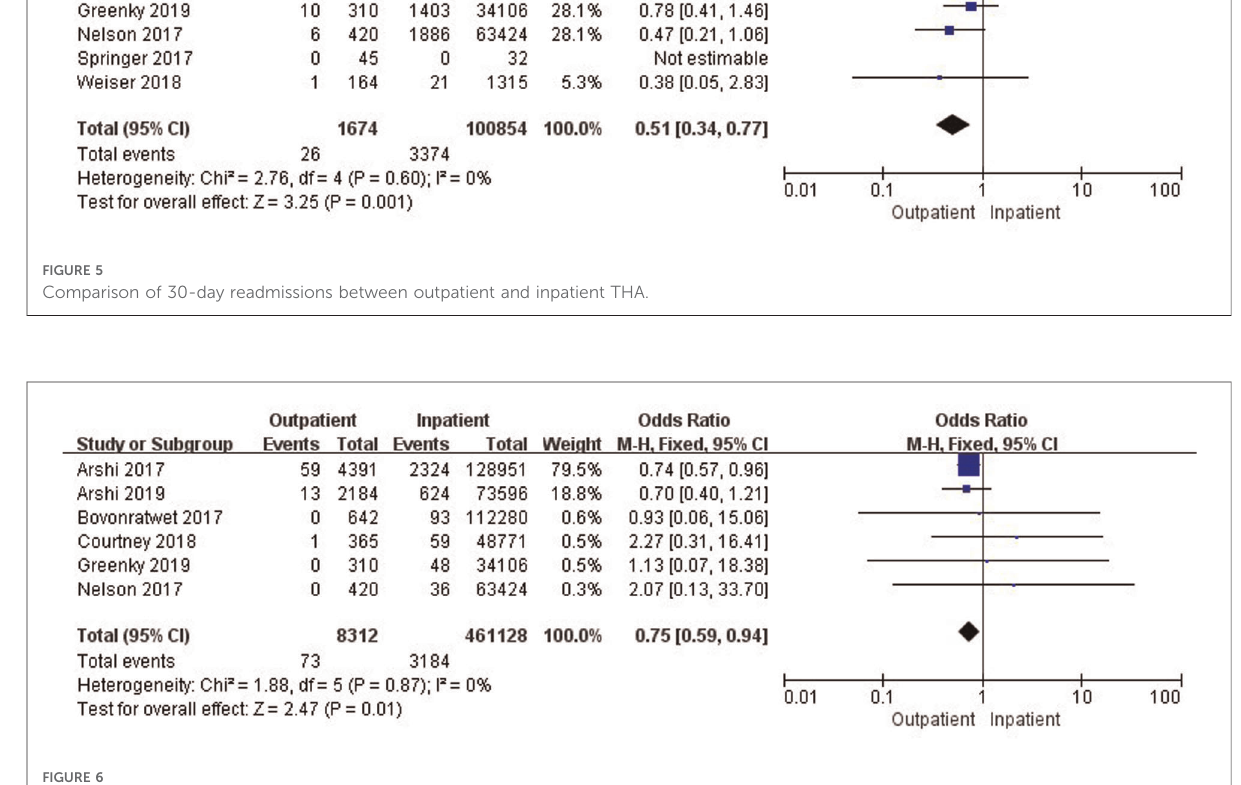
FIGURE 6 Comparison of 30-day stroke/cerebrovascular accidents between outpatient and inpatient TJA.